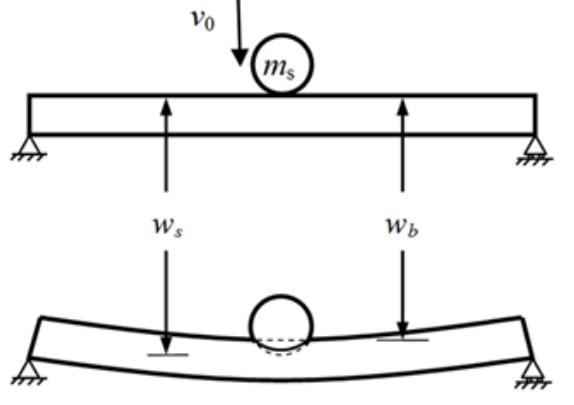
Figure 2. Sphere-beam impact system .